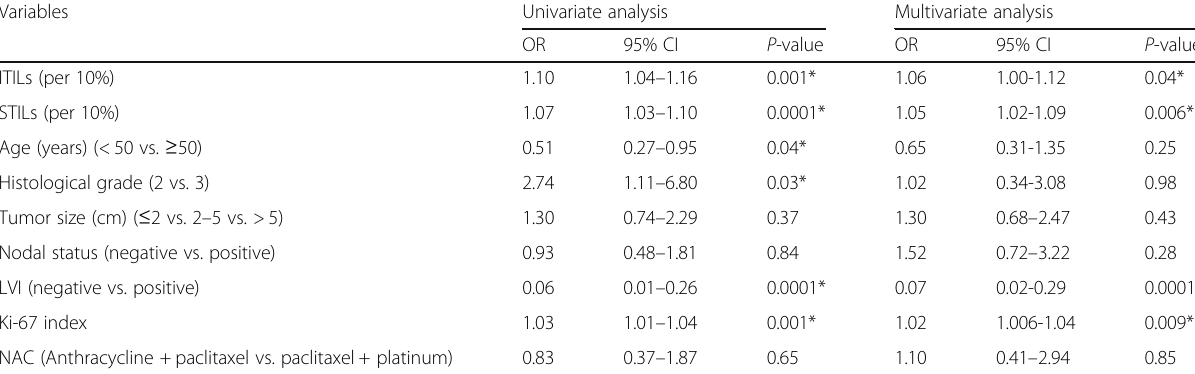
Table 3 Correlations between TILs and pCR in neoadjuvant treated TNBCs Variables Univariate analysis Multivariate analysis OR